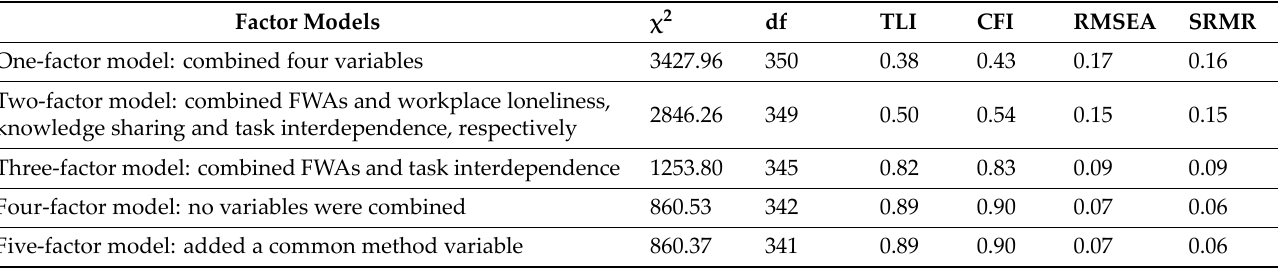
Table 1. Confirmatory factor analyses of Study